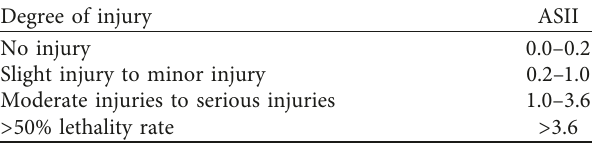
Table 1: ASII score corresponding to different injury levels. Degree of